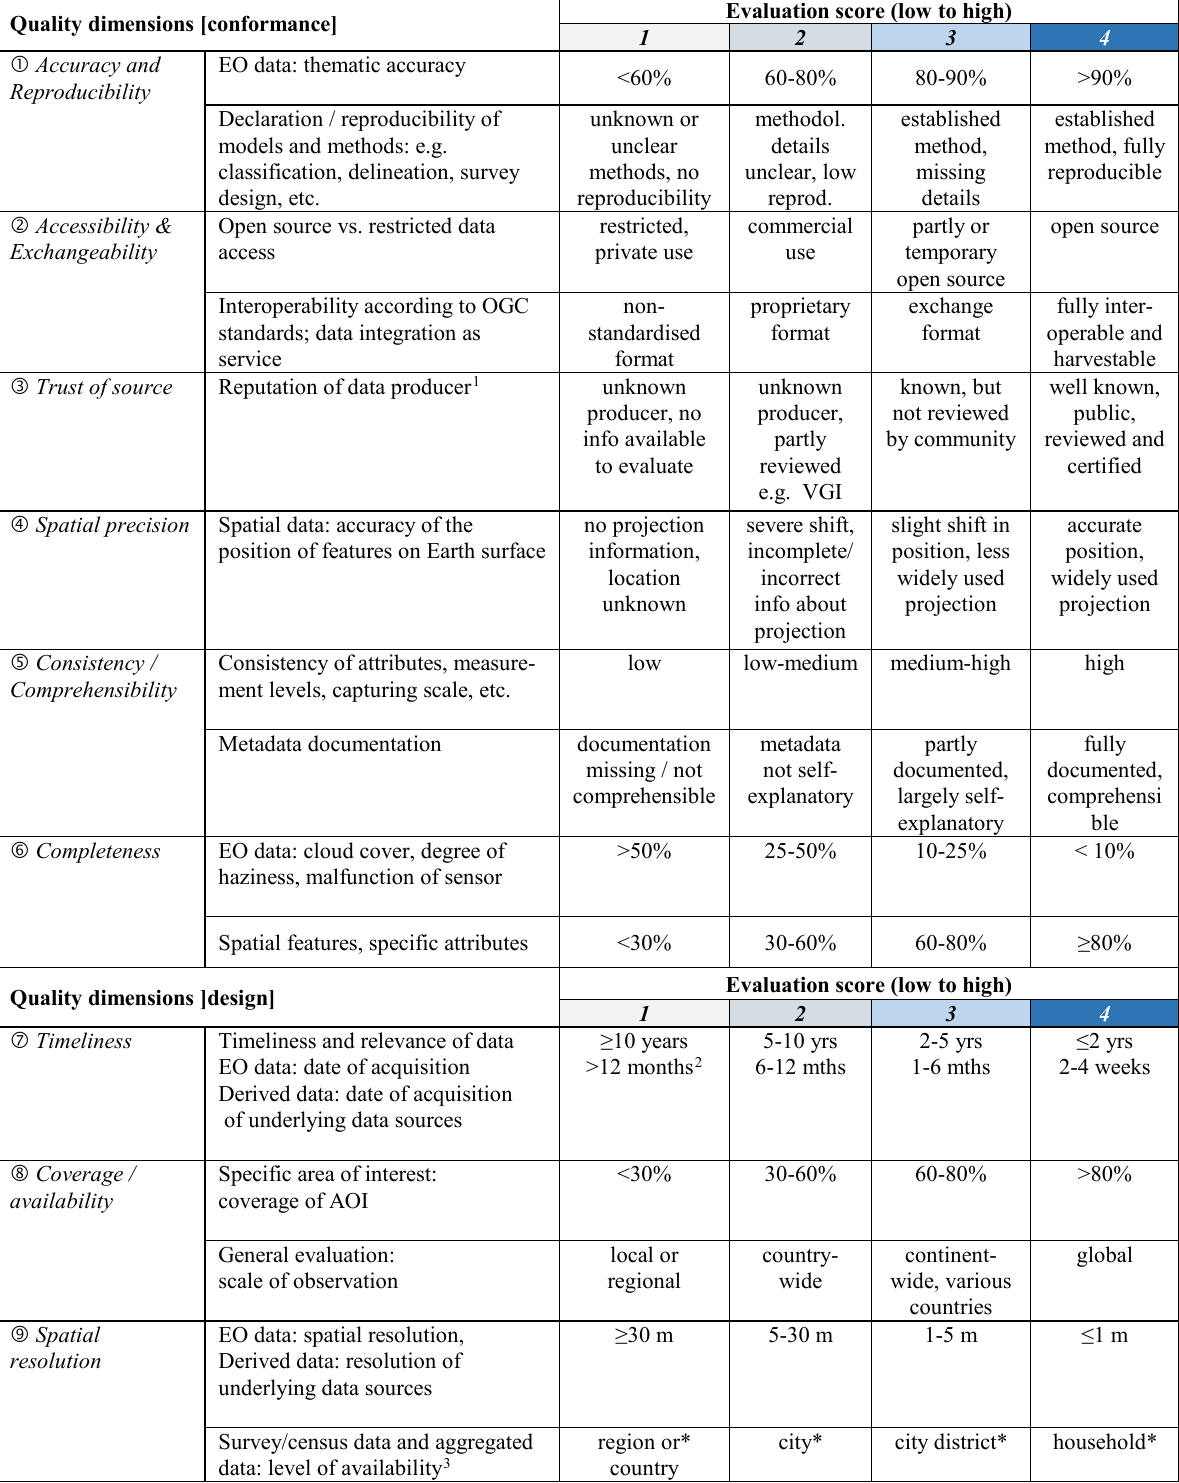
Quality dimensions